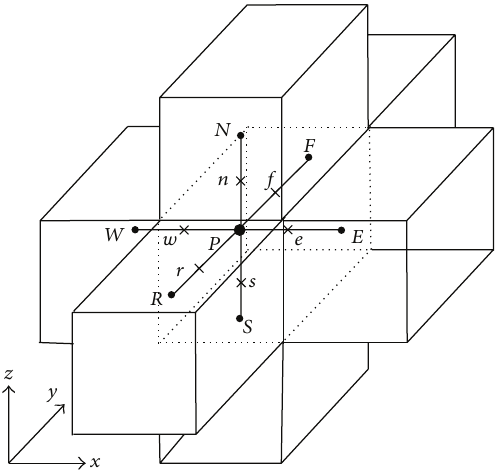
Figure 3: A control volume and the 6